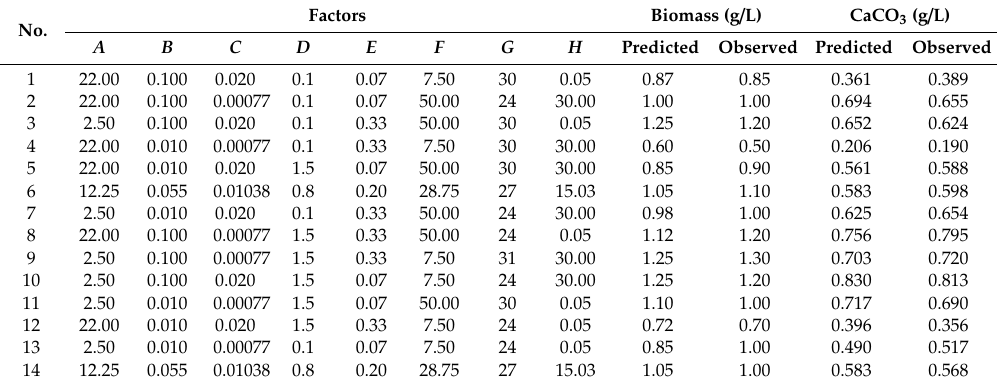
Table 1. Plackett–Burman Design of eight factors in actual levels with predicted and observed values of C. vulgaris biomass density and CaCO 3